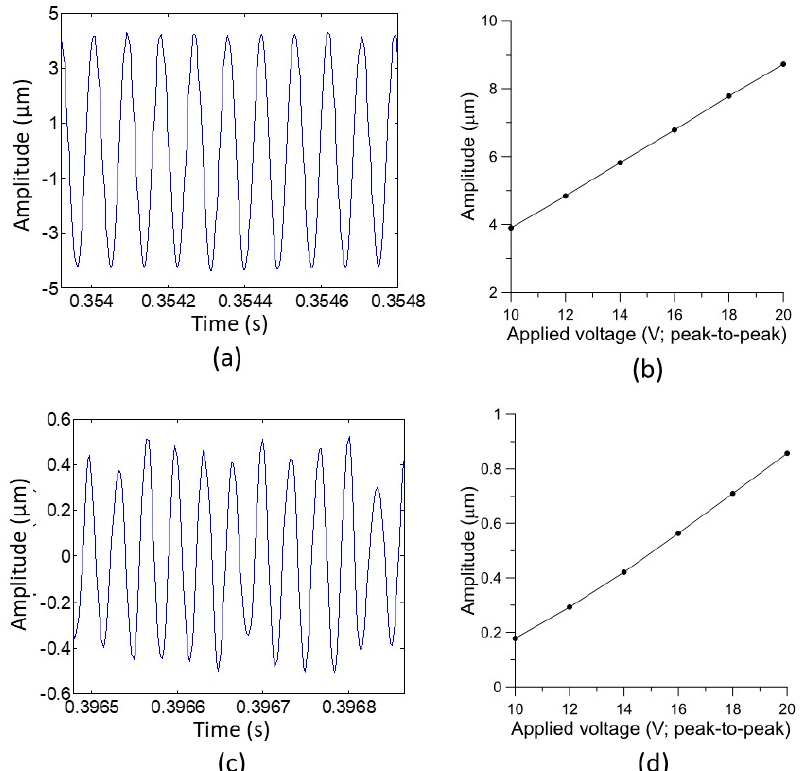
Figure 7. ( a , c ) Results of the measured displacement of the PMUT as a function of time with a 20 Vpp sinusoidal input voltage while being operated at the fundamental resonance and the fourth order resonance, respectively. ( b , d ) Results of measured displacements as a function of input voltages while being operated at the fundamental resonance and fourth order resonance, respectively.